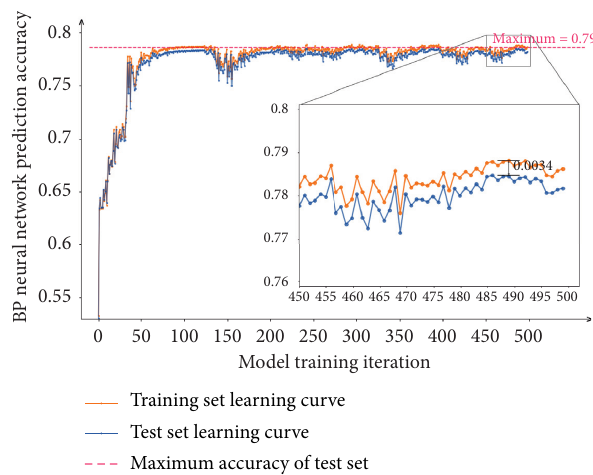
Figure 17: Learning curve of fatigue driving prediction model.